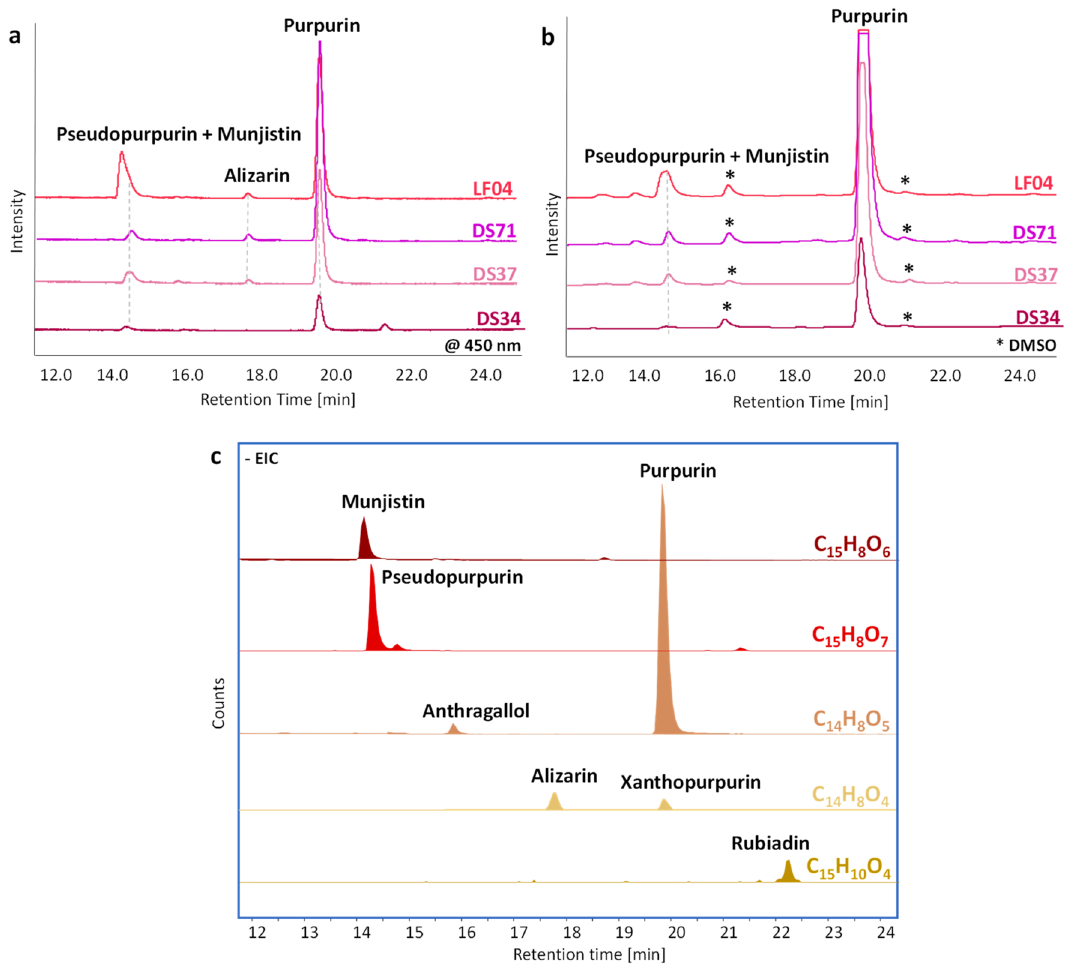
Figure 4. (a) HPLC–DAD acquired at 450 nm of LF04, DS71, DS37 and DS34 extracts; (b) HPLC-FD of LF04, DS71, DS37 and DS34 extracts; (c) HPLC-ESI-Q-ToF extract ion chromatograms (EICs) of anthraquinones (ions corresponding to the [M–H] − ions for the molecular formulas C 15 H 8 O 6 , C 15 H 8 O 7 , C 14 H 8 O 5 , C 14 H 8 O 4 , C 15 H 10 O 4 ) from the extracts of sample LF04. Negative acquisition